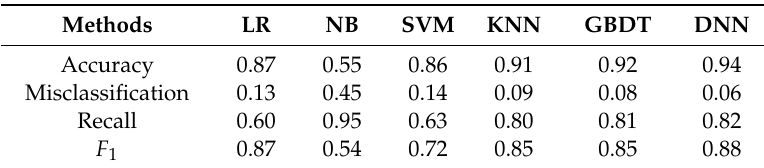
Table 2. The validation results of baseline models.